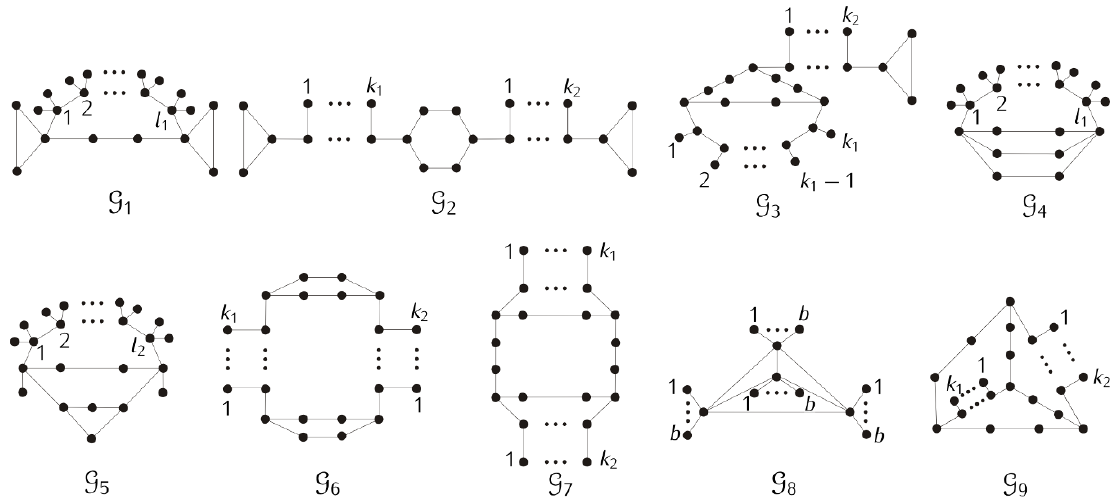
Figure 4. Graphs G i for i = 1 ,..., 9 , where l 1 ,b ≥ 1 , l 2 ≥ 0 and max {k 1 ,k 2 } ≥ 1